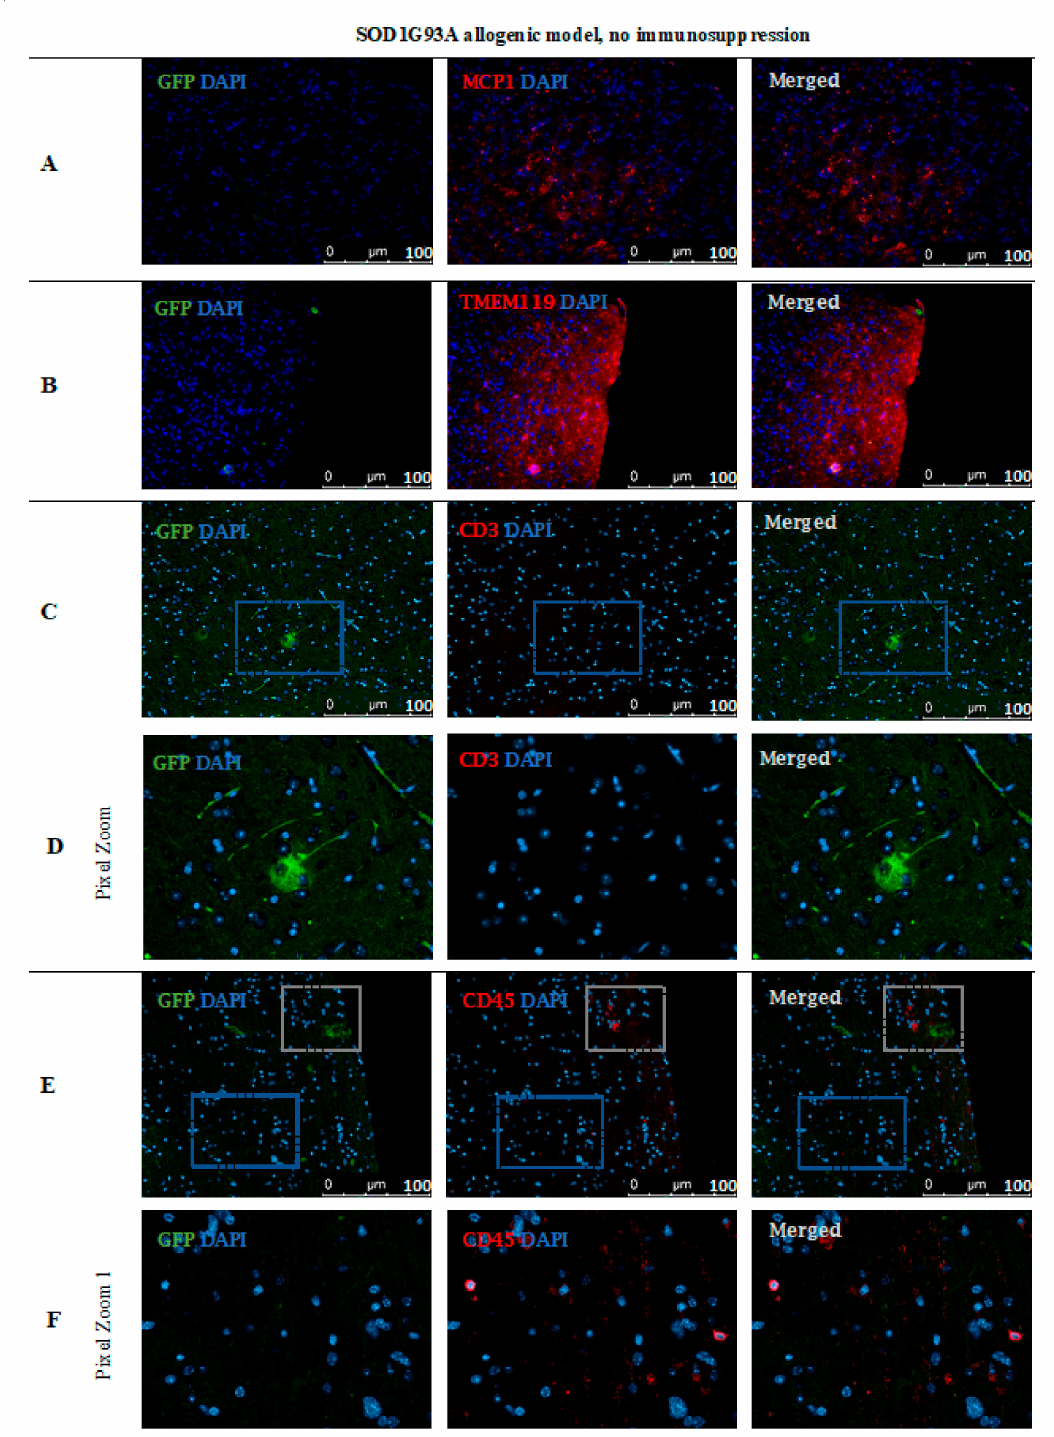
Figure 15. Cell localization post-mortem in ALS SOD1G93A mouse model without immunosuppression applied: Immuno- histochemical staining in ALS SOD1G93A (allogenic) mice after 56 days of observation in the group with no immunosup- pression applied. There were elevated MCP-1 levels ( A ) in the tissue, TMEM119 ( B ) and CD3+ ( C , D ), suggesting microglia activation. The GFP+ cells were very rare and the medium number of CD45+ cells with lymphocyte and macrophage morphology was present in the brain tissue ( E , F ) . Abbreviations: ALS-amyotrophic lateral sclerosis; GFP-green fluorescent